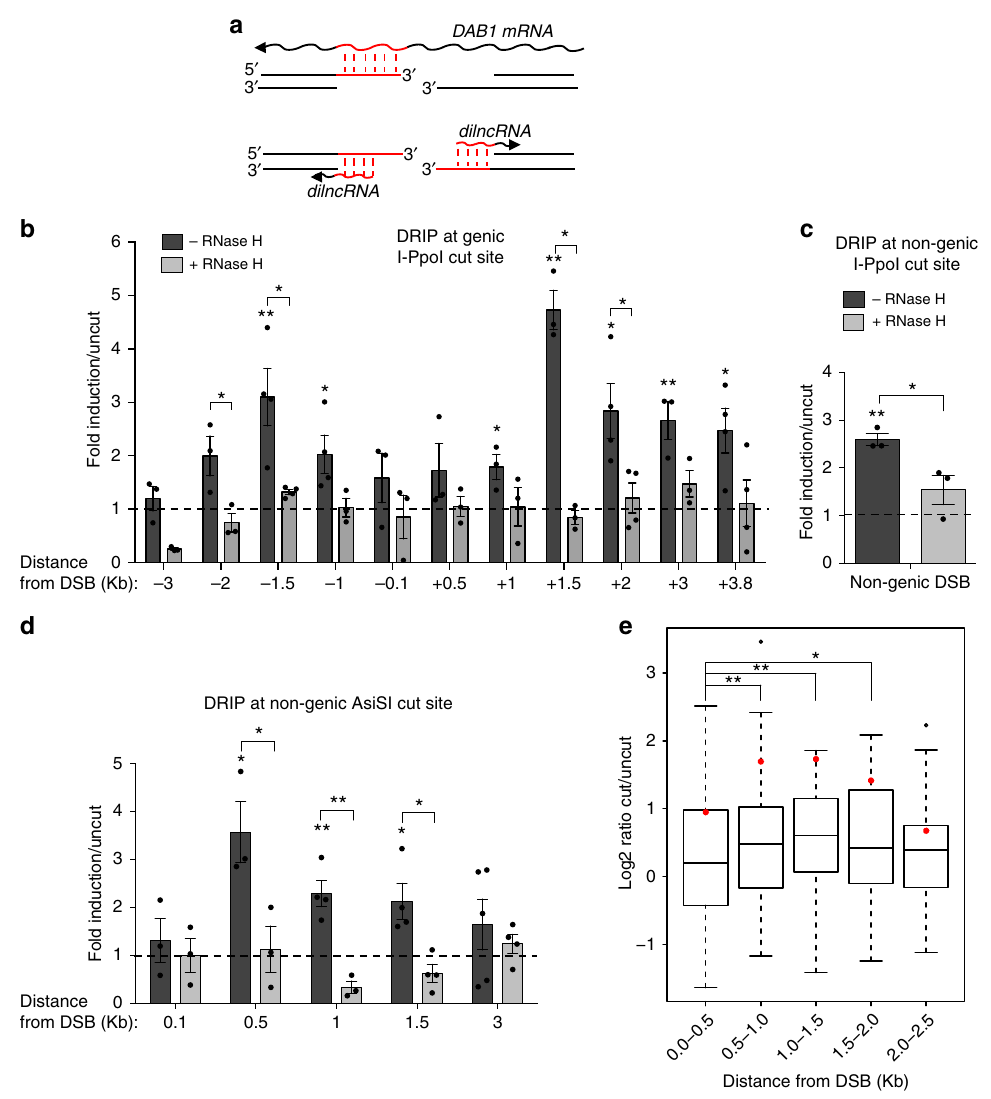
Fig. 1 DNA:RNA hybrids form at DSBs independently of the genomic context. a Schematic representation of DNA:RNA hybrids (in red) that can be generated upon the hybridization of mRNA (top) or dilncRNAs (bottom) with resected DNA ends at the I-PpoI cut site within DAB1 gene. b DRIP-qPCR analysis at the I-PpoI cut site within a genic ( DAB1 gene) or c nongenic locus in HeLa cells transfected with the I-PpoI nuclease. d DRIP-qPCR analysis at a nongenic AsiSI cut site in DIvA cells. Bar graphs in b , c and d show fold induction of DNA:RNA hybrid levels in cut samples relative to uncut. RNase H treatment was performed on cut samples to demonstrate speci fi city of the signal. Error bars represent s.e.m. ( n ≥ 3 independent experiments). * P < 0.05, ** P < 0.01 (two-tailed Student ’ s t test). e Boxplot representing log2 ratio of the fold change of DNA:RNA hybrid reads in cut compared to uncut samples at the BLISS detected top 50 cut AsiSI sites at different distances from the DSBs. * P < 0.05, ** P < 0.01 (Wilcoxon signed-rank test). Source data are provided as a Source Data fi